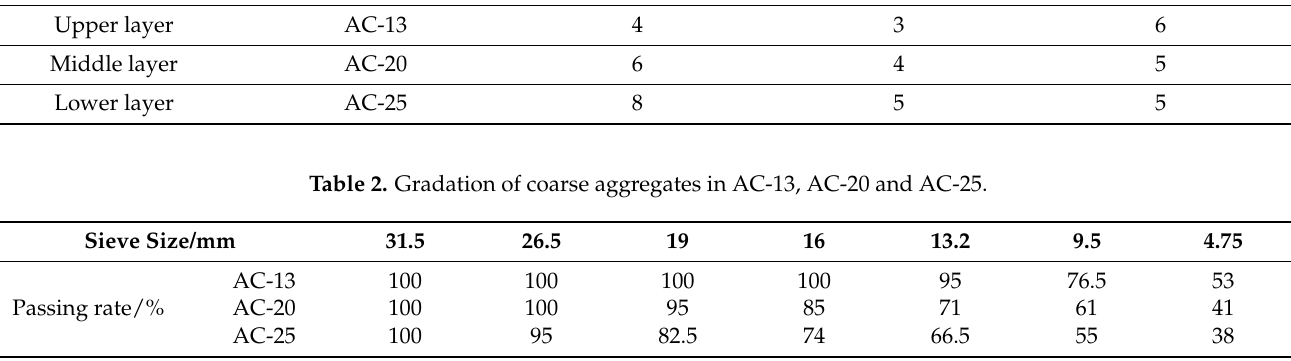
Table 1. Pavement structure combination and parameters.